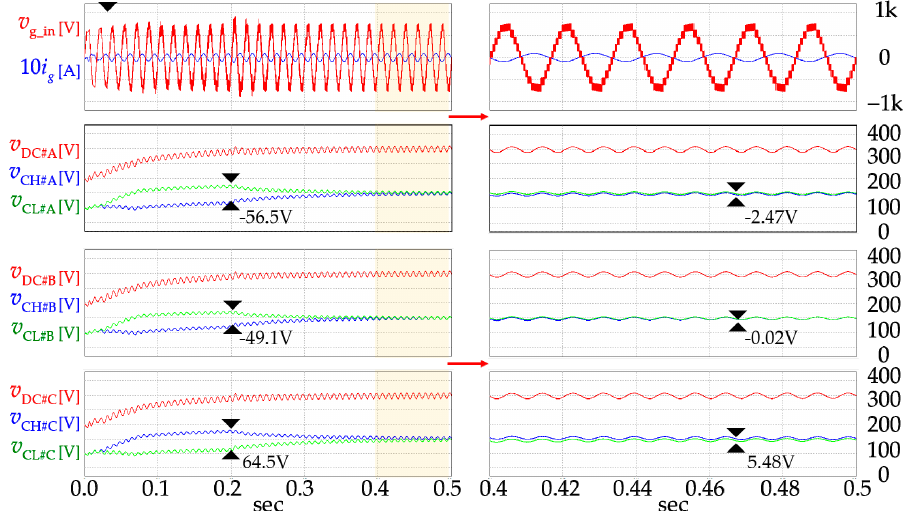
Figure 6. DC-link voltage control of multi-module NPC inverter with voltage balancing control.